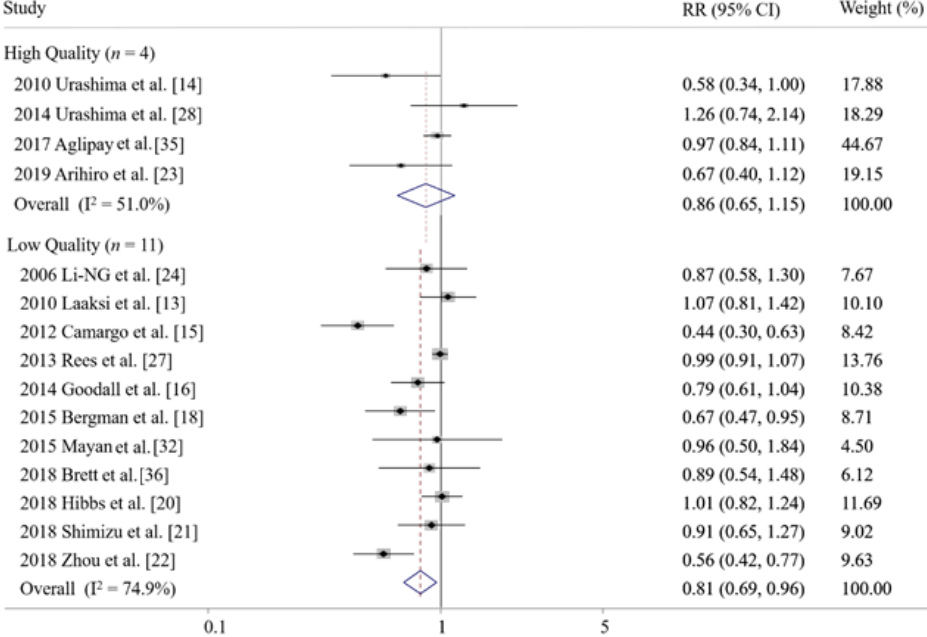
Figure 4. Efficacy of daily supplementation of vitamin D in prevention of acute respiratory infec-